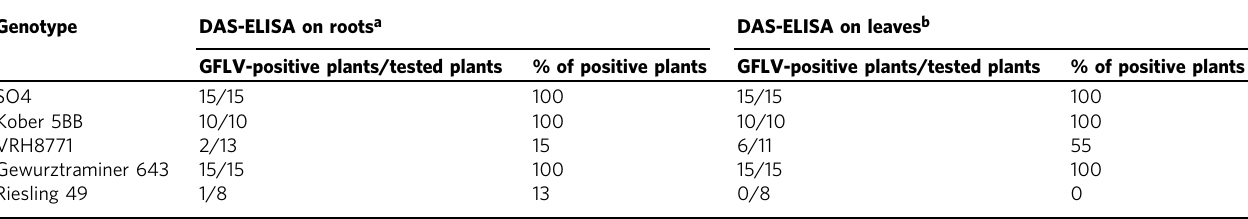
Table 2 Infection tests of fi ve genotypes of grapevine varieties or rootstocks. Genotype